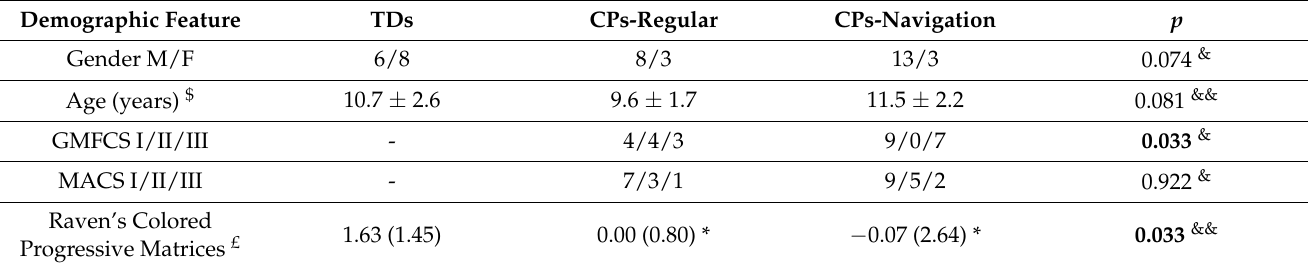
Table 1. Demographic features of